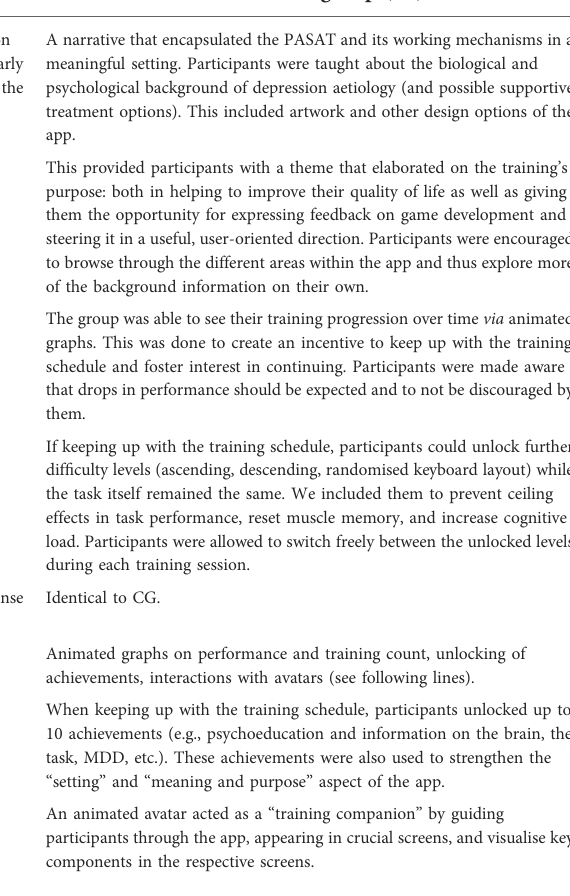
TABLE 1 Comparison between the apps that CG and IG received. Topic Setting